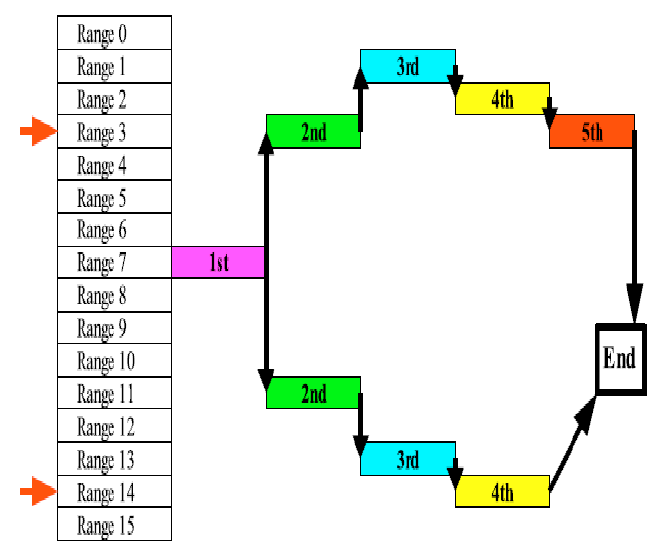
Figure 8a. Auto-Ranging Feature to Determine Location of Sensor Data.